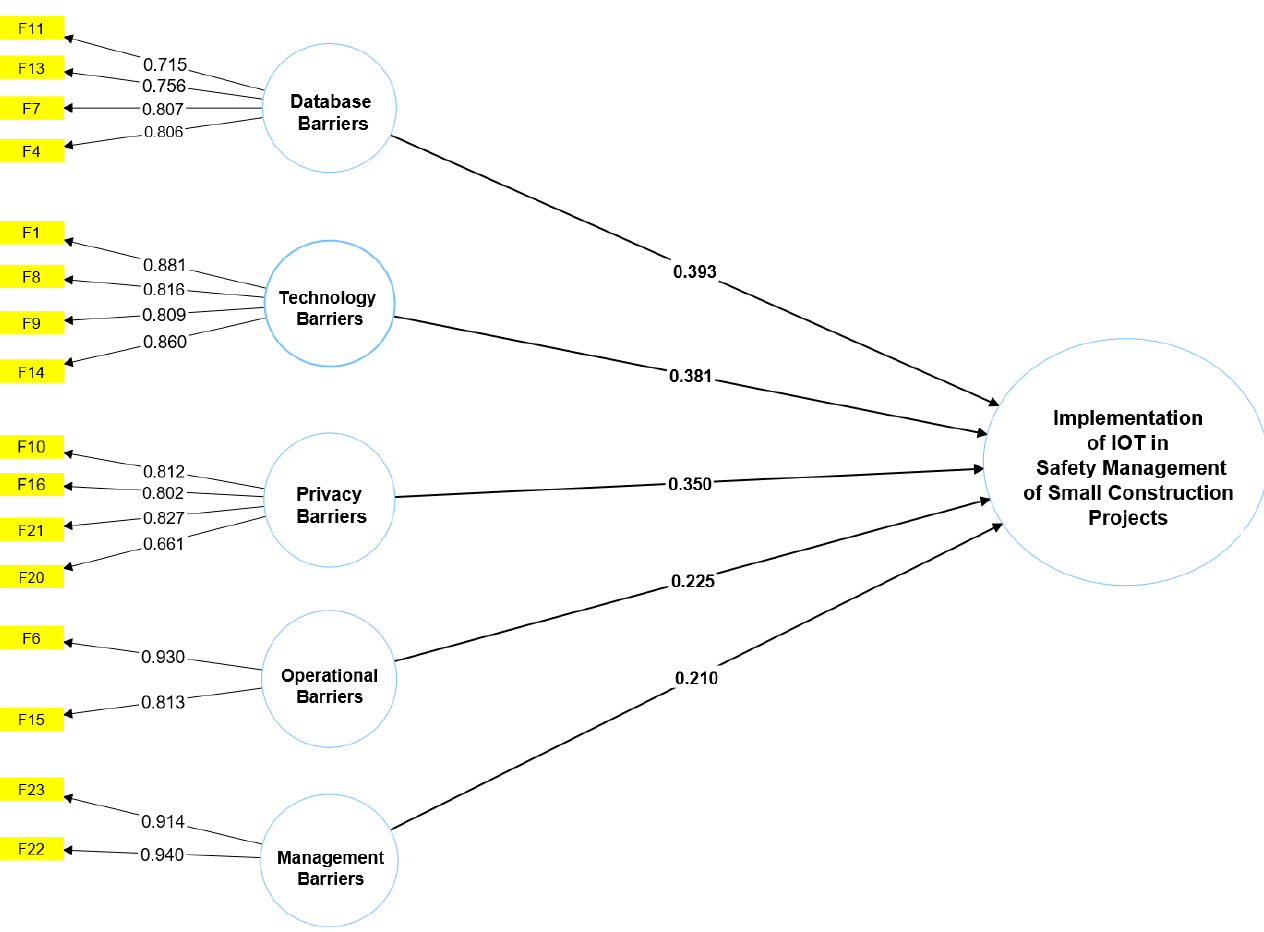
Figure 3. Developed structural model.